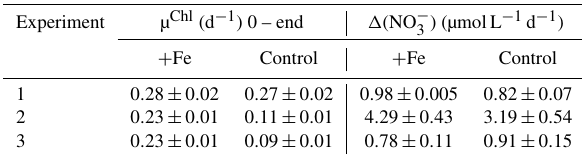
Table 2. Net growth rates calculated from Chl a accumulation (µ Chl ) and nitrate drawdown ( (cid:49) (NO − )) over the full experimen- 3 tal running time ( t = 168 , 168 , 144h). Shown are averages with ± standard deviations, where n = 6 − 12 for Chl a and n = 6 − 7 for nitrate (see Table S1 for specific